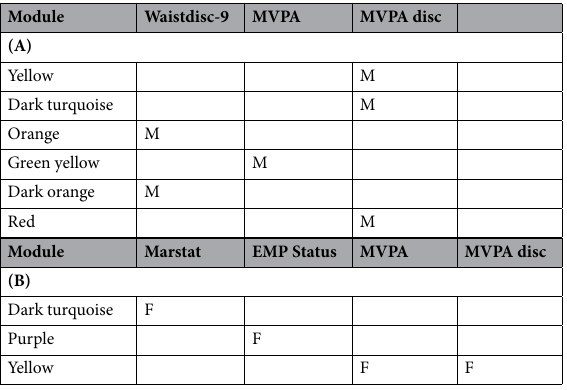
Table 1. (A) Male (M) and (B) female (F) summary module-trait correlations p <